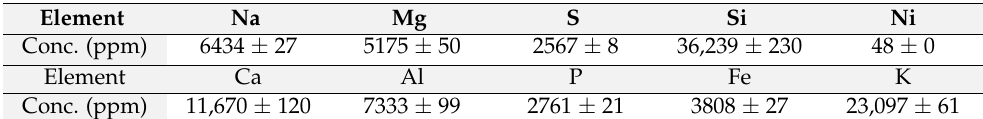
Table 1. Metal contents in the corn